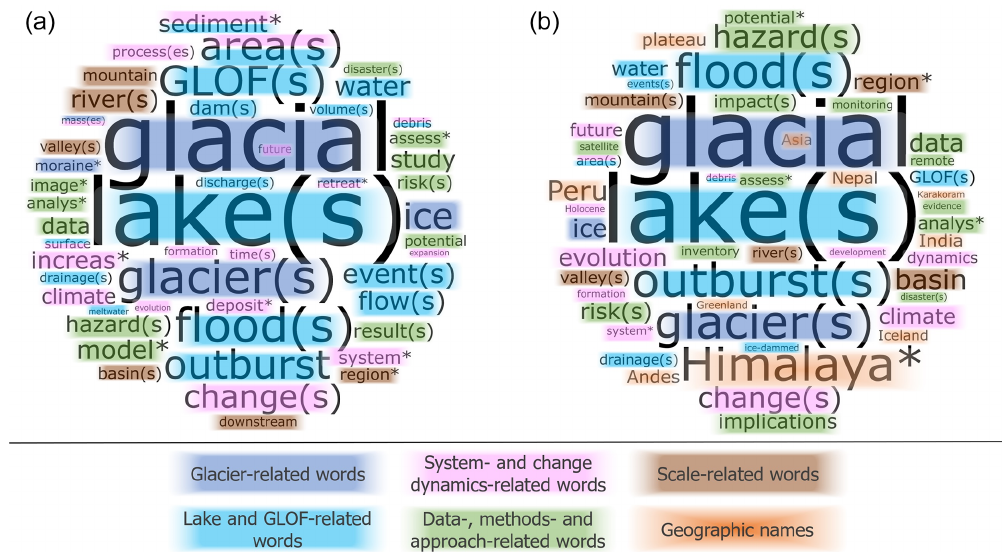
Figure 2. Word clouds of abstracts (a) and titles (b) of GLOF papers. The size of individual words indicates frequency of occurrence while the background colour groups individual words into thematic clusters. The 50 most frequently occurring words are shown in both word